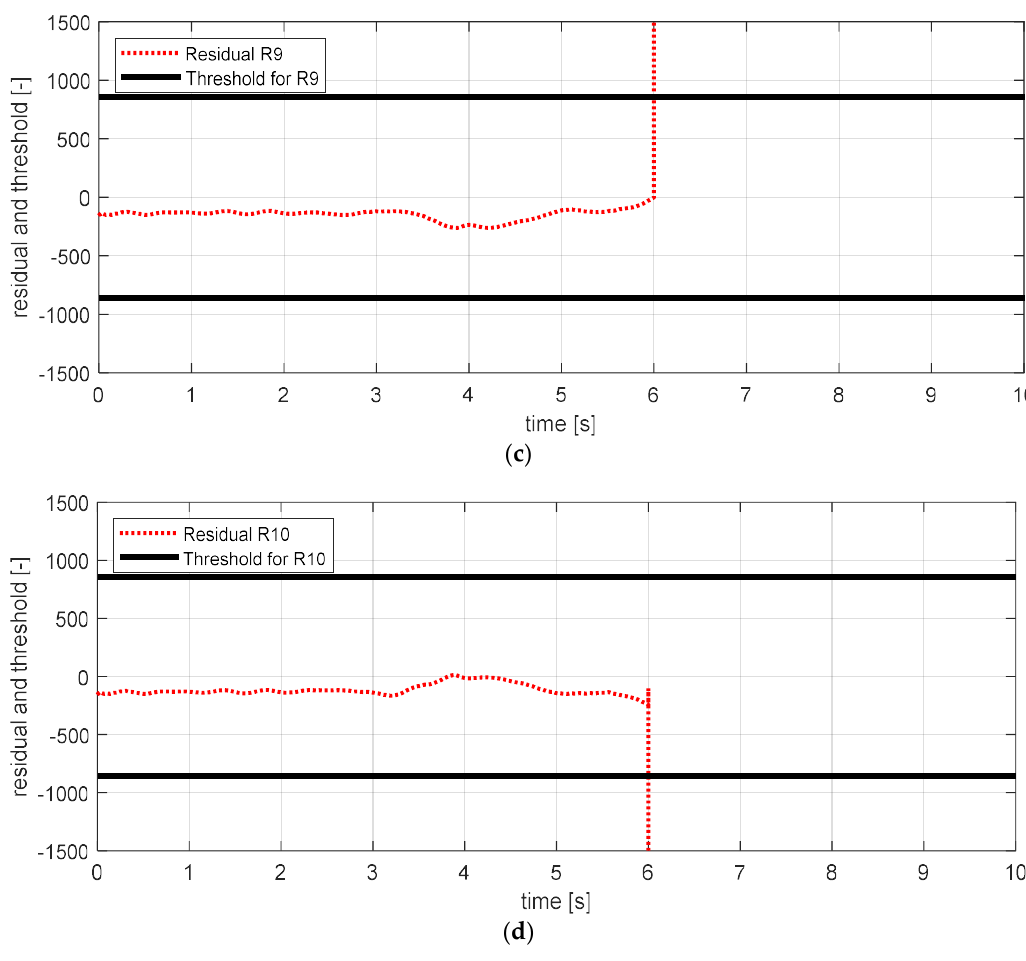
Figure 20. FDI simulation result for longitudinal acceleration sensor (fault). ( a ) Residual 7 and threshold; ( b ) residual 8 and threshold; ( c ) residual 9 and threshold; ( d ) residual 10 and threshold.